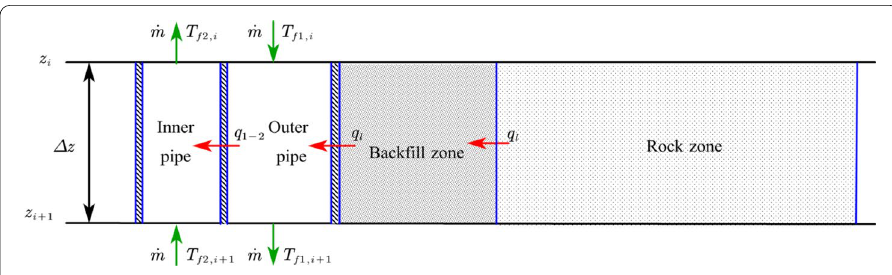
Fig. 6 Quasi–steady state heat transfer analysis based on energy equilibrium inside the